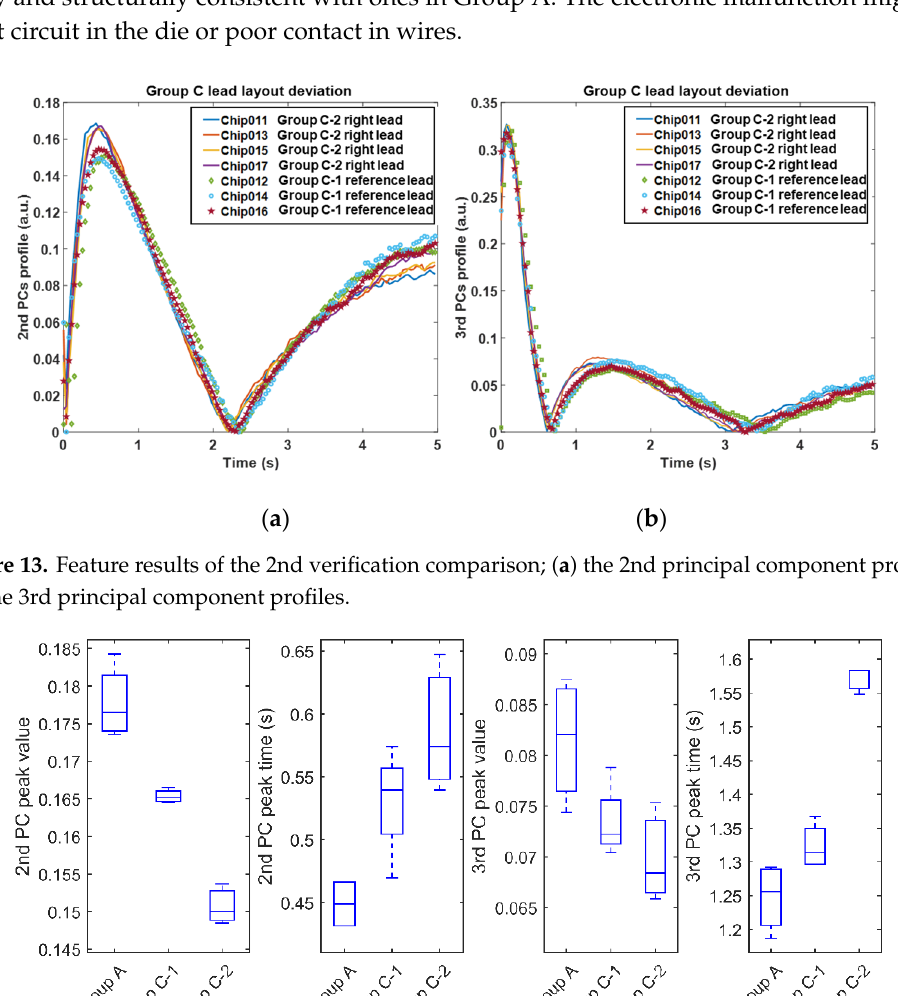
Figure 14. Quantitative comparisons of peak features among three groups in the experiments (Group C-1: Chips with Reference lead layout in Group C; C-2: Chips with Right lead layout in Group C).